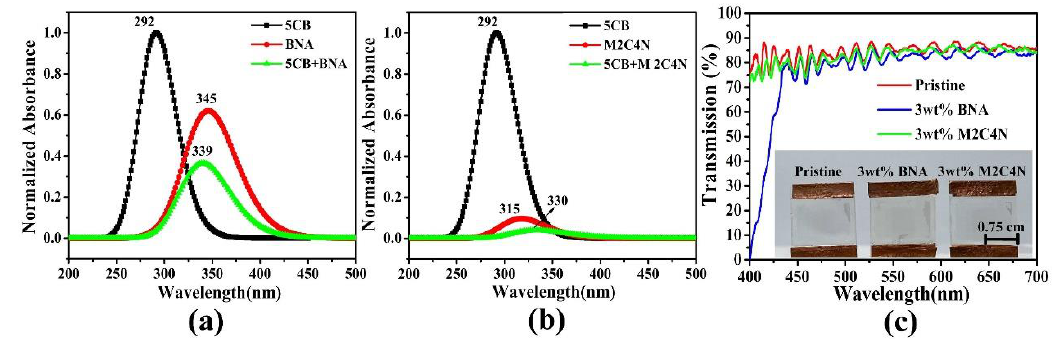
Figure 6. ( a )Theoretical absorption spectra for 5CB, BNA, 5CB + BNA, ( b )5CB, M2C4N, and 5CB + M2C4N by using DFT. ( c ) Transmission spectra of the BNA and M2C4N-doped LC cells. Inset shows the sample photos of the pristine LC E7, 3 wt% BNA-doped, and 3 wt% M2C4N-doped LC cells under daylight illumination.